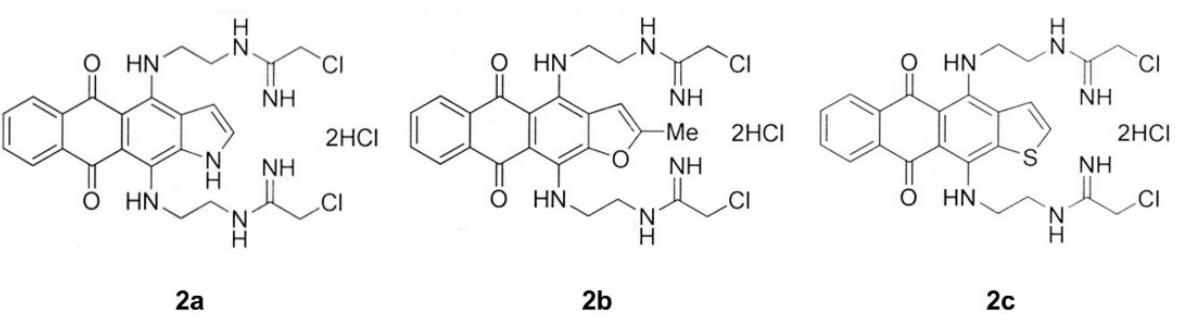
Figure 1. Structures of bis(chloroacetamidino)heteroareneanthraquinones 2a – c .